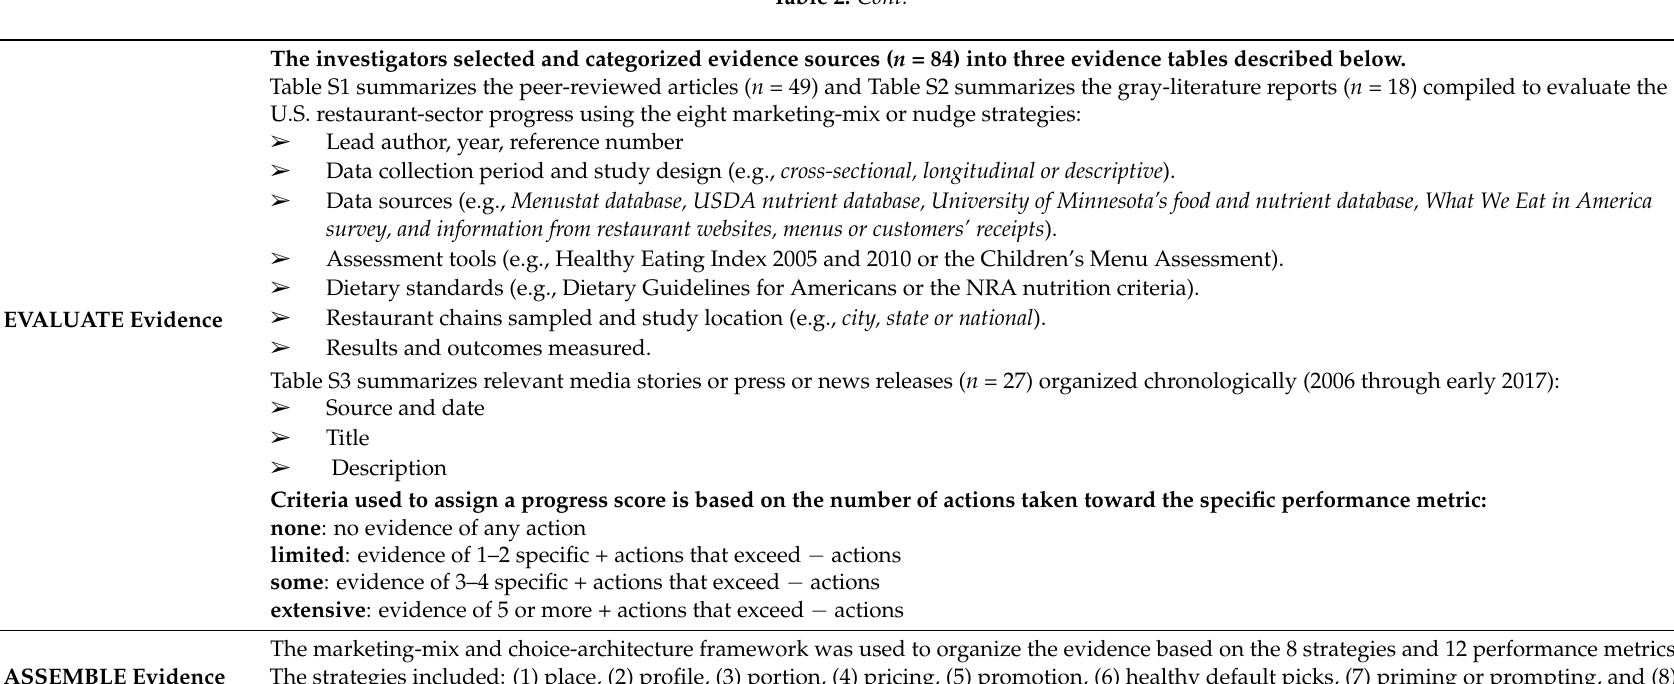
The investigators selected and categorized evidence sources ( n = 84) into three evidence tables described below. Table S1 summarizes the peer-reviewed articles ( n = 49) and Table S2 summarizes the gray-literature reports ( n = 18) compiled to evaluate